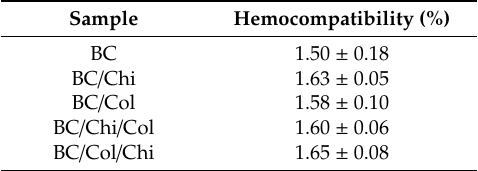
Table 4. Hemocompatibility percentage of BC, BC / Chi, BC / Col, BC / Chi / Col, BC / Col / Chi ( n =